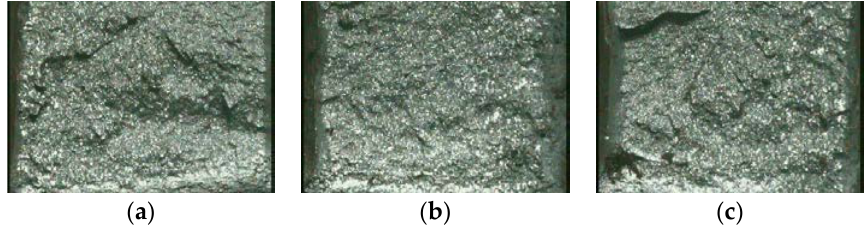
Figure 2. Macroscopic fracture ( − 40 °C): ( a ), impact fracture of 16 mm thickness plate; ( b ), impact fracture of 25 mm thickness plate; ( c ), impact fracture of 40 mm thickness plate.